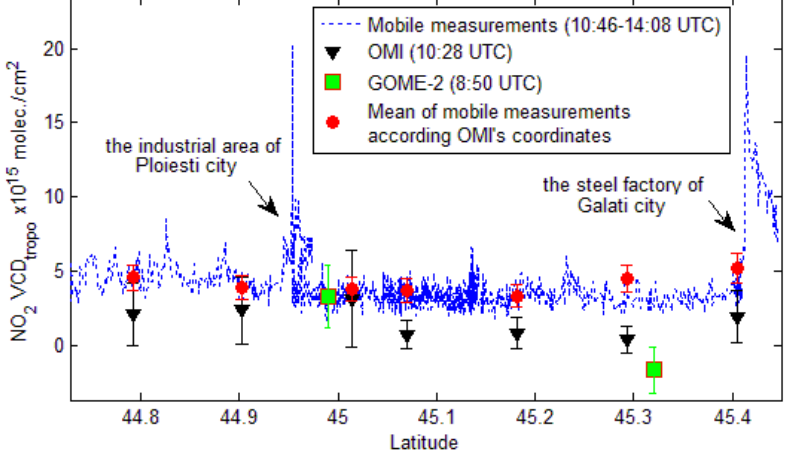
Figure 11. Comparison of tropospheric NO measurements with OMI and GOME-2 observations (22 August 2011) and the corresponding error bars.